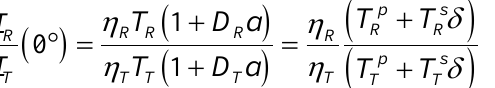
which correspond to the transmitted and reflected intensities, include the individual channels gains η which are the product of the electronic amplification of the detectors, the amplifiers, and of the optical attenuation due to polarisation insensitive attenuation of all optics including neutral density and interference filters. The latter is in general different in the two channels. We can solve the equation of the ratio of the measured reflected to the transmitted signals